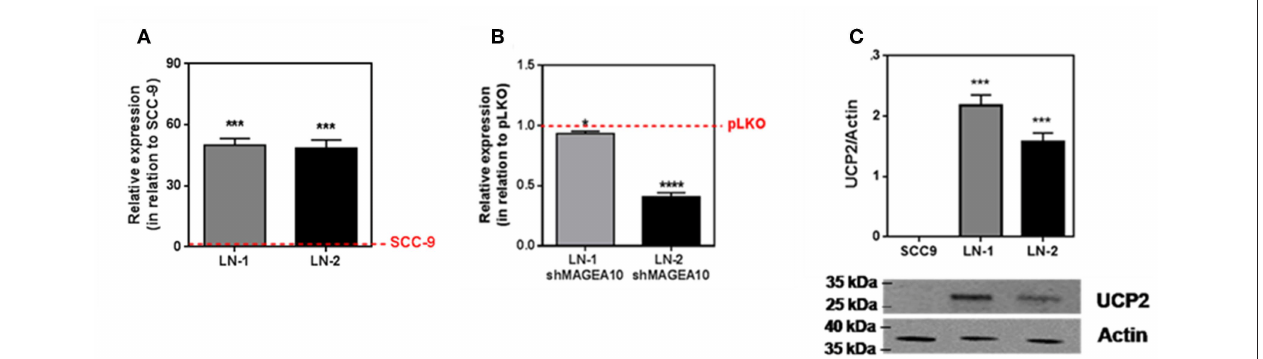
FIGURE 4 | UCP2 mRNA and protein expression in human oral squamous carcinoma cells SCC-9, LN-1 and LN-2. (A) UCP2 mRNA levels in LN-1 and LN-2 cells relative to SCC-9 cells; (B) mRNA expression levels of UCP2 in cells supressed relative to pLKO. SCC-9 and pLKO (red line), LN-1 (gray bar) and LN-2 (black bar). (C) Protein levels of UCP2 in cells grown as monolayers quantified from the western blot shown in the inset. The values were expressed in relation to the red dashed lines. Values were expressed as mean ± SEM. * p < 0.05; *** p < 0.001; **** p < 0.0001.